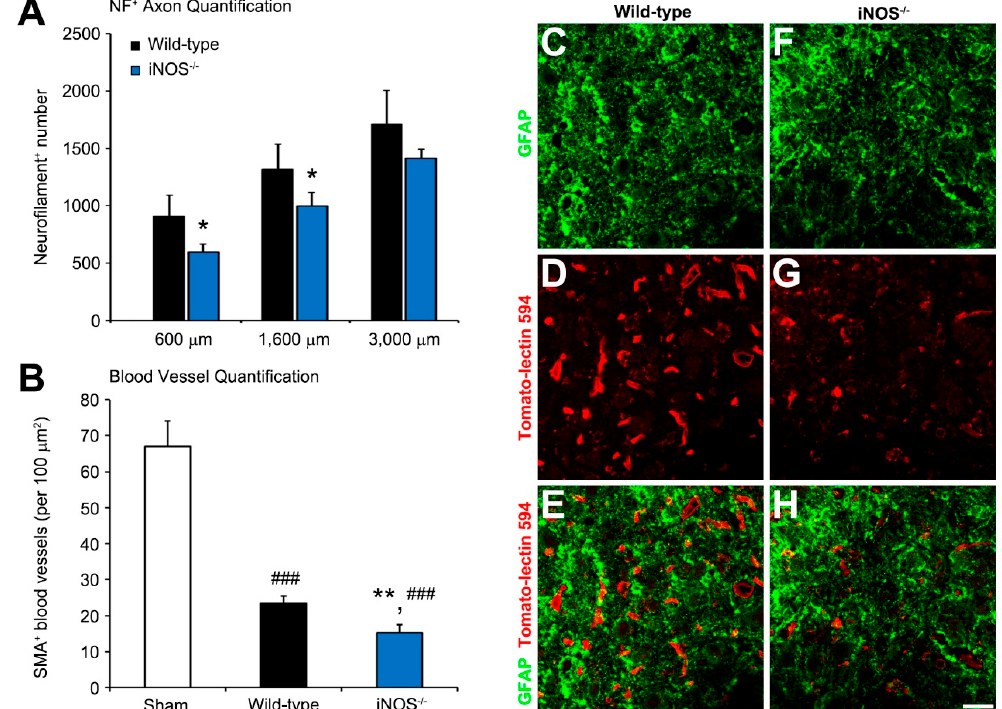
Figure 2. Numbers of dorsal column neurofilament (NF) + axons and perilesional blood vessels within the spinal cord rostral to the spinal cord injury (SCI) were significantly fewer in inducible nitric oxide synthase ( iNOS ) knockout mice than wild-type (WT) controls. Counts of dorsal column axons at six weeks post-SCI within tissue sections at specific distances rostral to the injury showed that iNOS − / − mice exhibited fewer NF + axons at 600, 1600, and 3000 µm, rostral to the SCI epicenter compared to WT controls ( A ); At six weeks post-SCI, iNOS − / − mice also displayed 35% fewer perilesional smooth muscle action (SMA) + blood vessels compared to WT controls ( B ); Both iNOS − / − and WT control groups demonstrated substantially fewer perilesional blood vessels ( − 77% and − 65% respectively) when viewed against a comparable uninjured spinal cord region from sham controls. Representative micrograph images of similar regions of perilesional lateral white matter from the spinal cord rostral to the SCI of ( C – E ) WT and ( F – H ) iNOS − / − mice immunostained for glial fibrillary acidic protein (GFAP) and Tomato-lectin-594 were used to identify astrocytes and blood vessels, respectively. Significantly fewer blood vessels were identified within iNOS − / − mice at six weeks after SCI. Statistical significance indicated at * p < 0.05 or ** p < 0.01 versus injured WT controls and ### p < 0.001 versus sham controls. Scale bar = 25 µm.